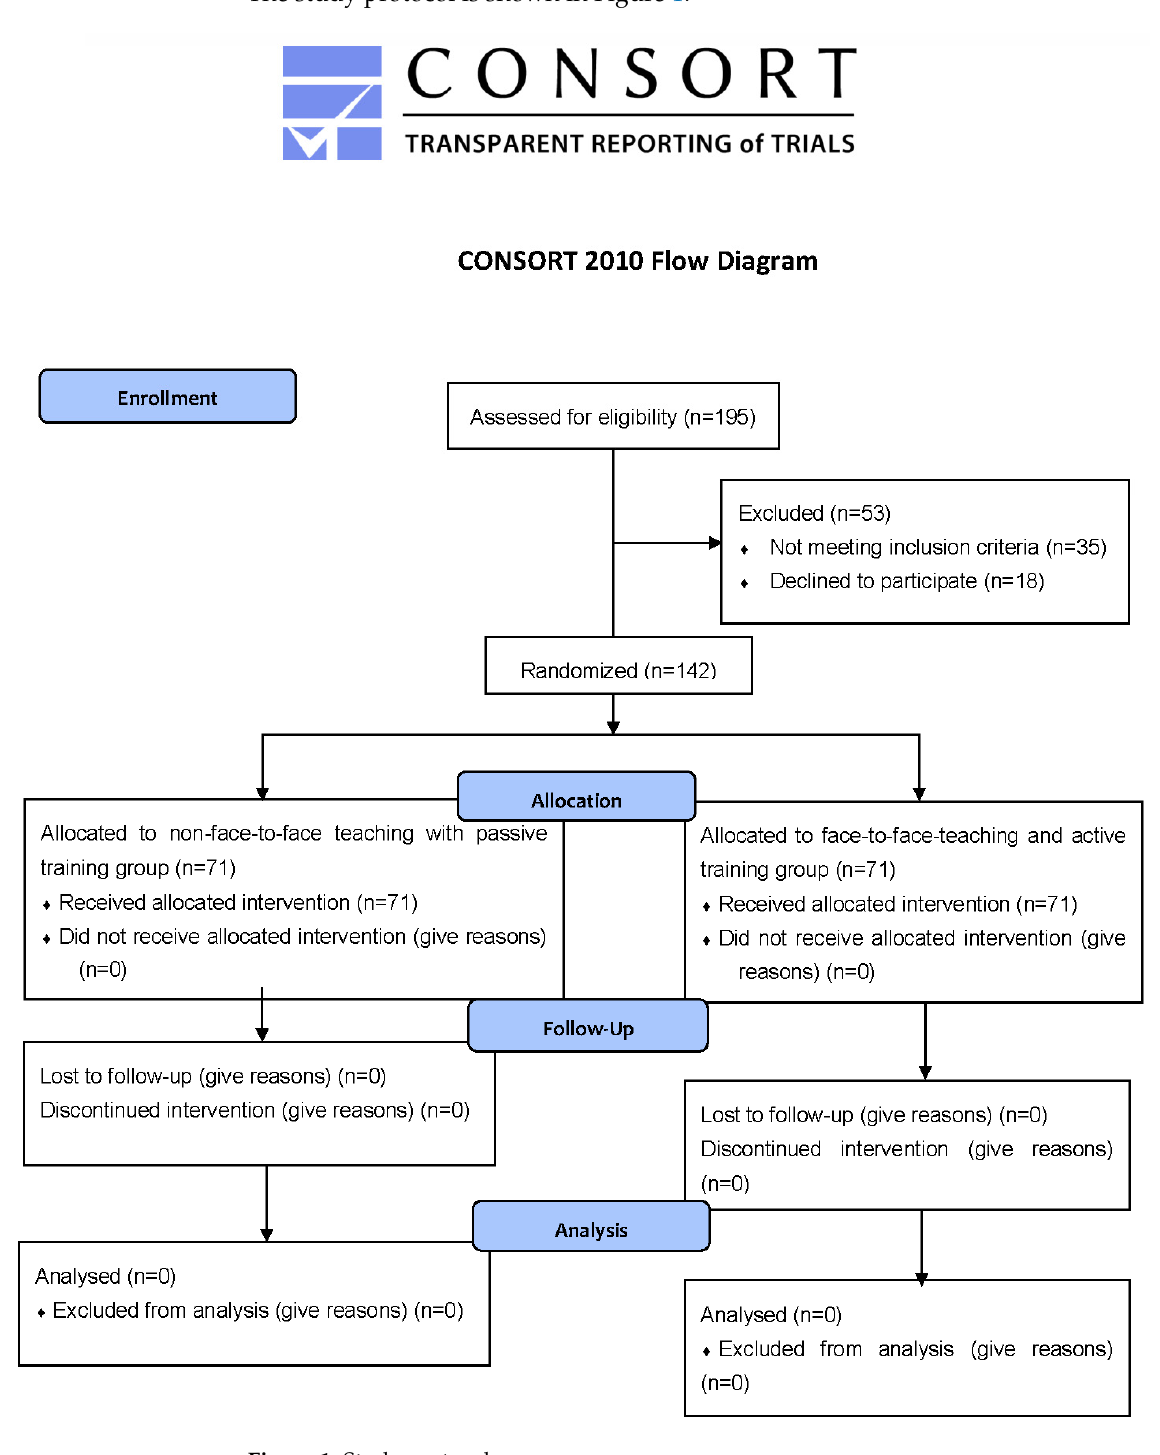
Figure 1. Study protocol .